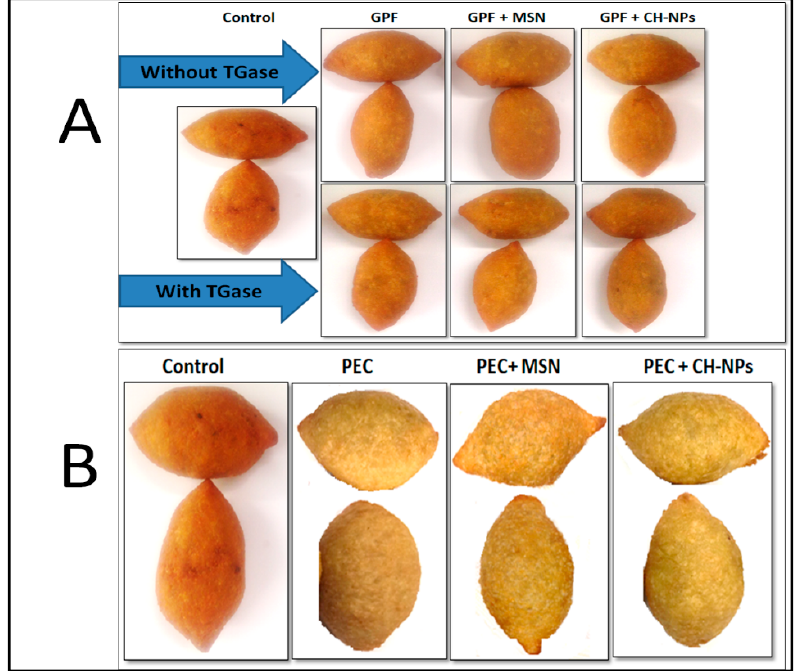
Figure 5. Images of kobbah samples coated by hydrocolloid coatings made of grass pea flour (GPF), GPF + mesoporous silica nanoparticles (MSN), GPF + chitosan nanoparticles (CH–NP), GPF + transglutaminase (TGase); GPF + MSN + TGase and GPF + CH–NP + TGase (Panel A ); pectin (PEC), PEC + MSN and PEC + CH–NP (Panel B ). “Control” represents the kobbah sample dipped in distilled water.